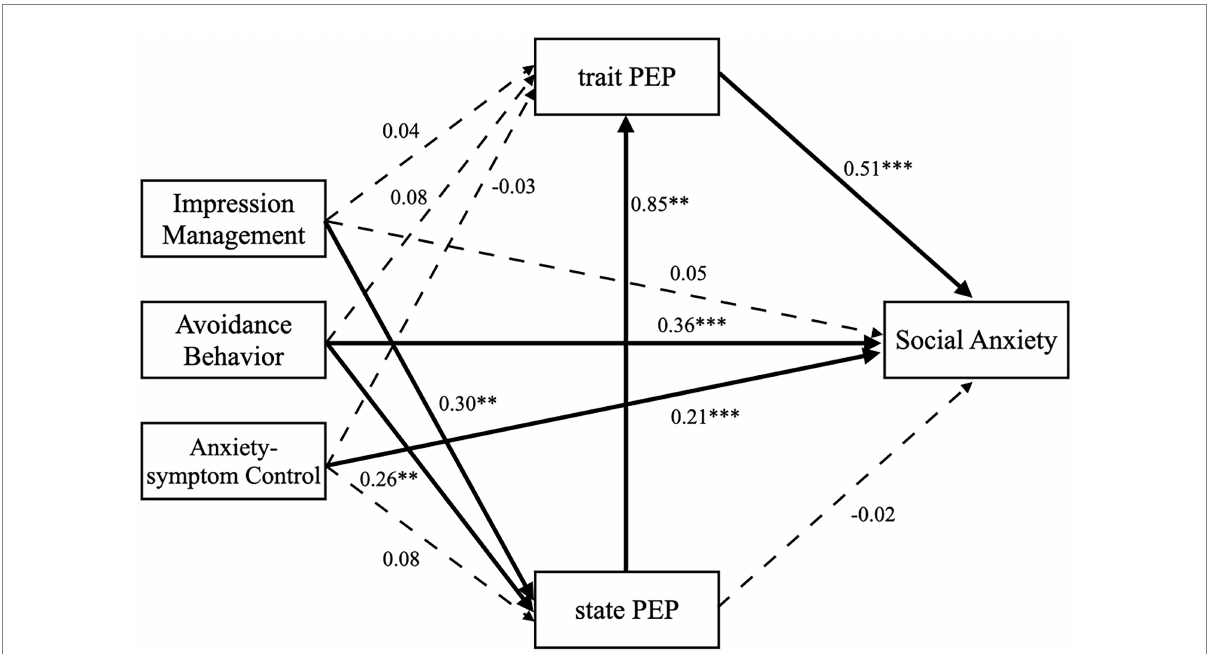
FIGURE 1 The serial mediation effects between the three subtypes of safety behavior and social anxiety in high SA group. The dotted lines represent non- significant paths, and the solid lines represent significant paths, ** p < 0.01 and *** p < 0.001.